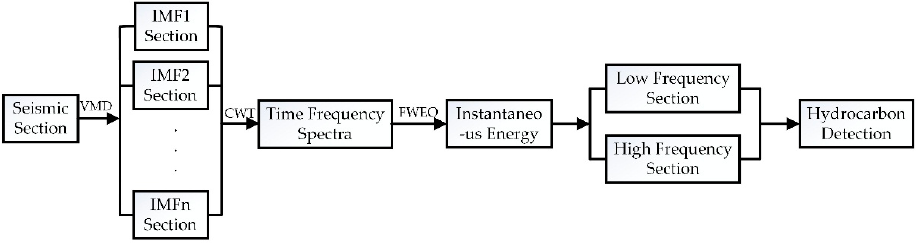
Figure 1. A flowchart of the VMD/CWT/FWEO method.